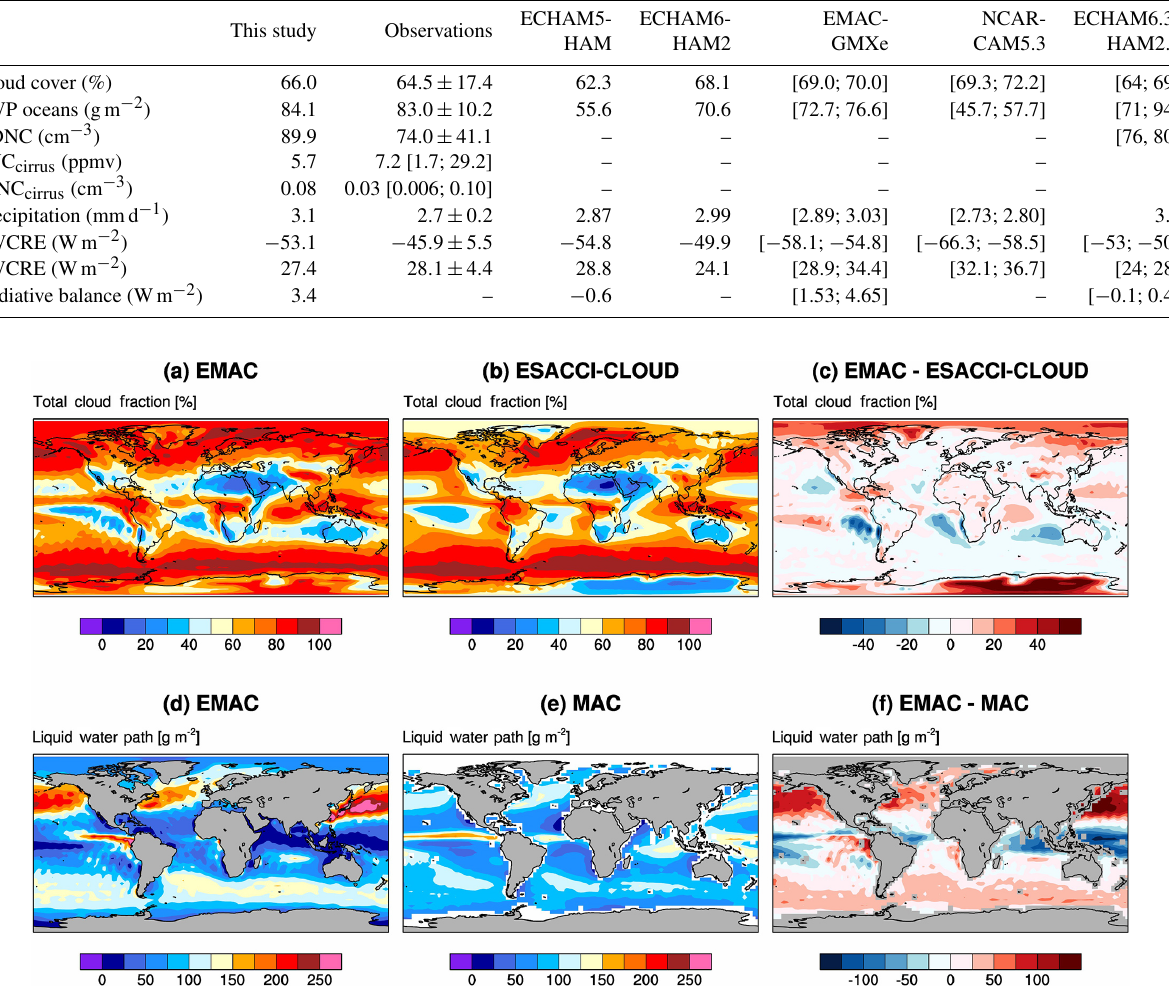
Figure 2. Multi-year (1996–2005) average total cloud cover (a–c) and liquid water path (d–f) simulated by EMAC (a, d) , in the satellite data (b, e) , and the difference between model and observations (c, f)